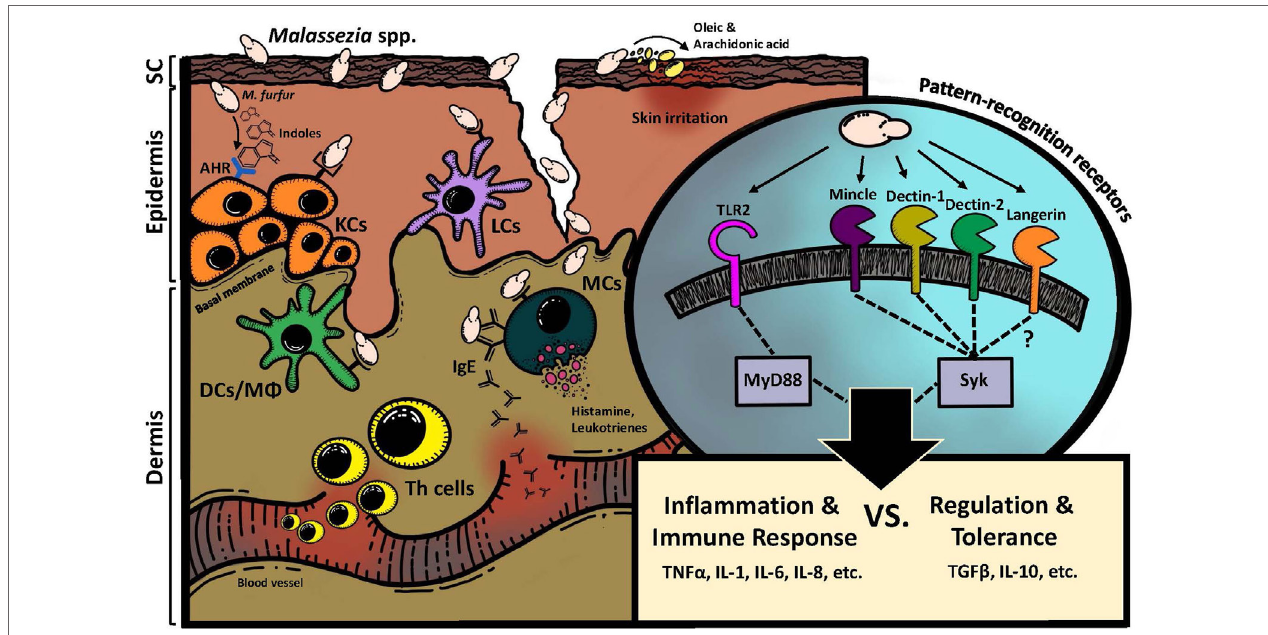
FiGURe 1 | Interaction of Malassezia spp. with the mammalian skin. Direct interactions involve various PRRs, which recognize fungal cell wall constituents and are distinctly expressed on the surface of non-hematopoietic (i.e., keratinocytes) and hematopoietic cells (i.e., Langerhans cells, mast cells) of the skin. Spatial and temporal signal integration of different PRR signals results in the induction of inflammation and immunity or, alternatively, in the regulation and tolerance of the host toward Malassezia spp. Indirect interactions of Malassezia spp. with the skin include fungus-derived metabolites such as irritant fatty acids on the one hand and indoles that are potent agonists for the AhR, which is expressed by various skin cells, on the other hand. KCs, keratinocytes; LCs, Langerhans cells; DCs, dendritic cells; M ϕ , macrophages; MCs, mast cells; SC, stratum corneum; AhR, aryl hydrocarbon